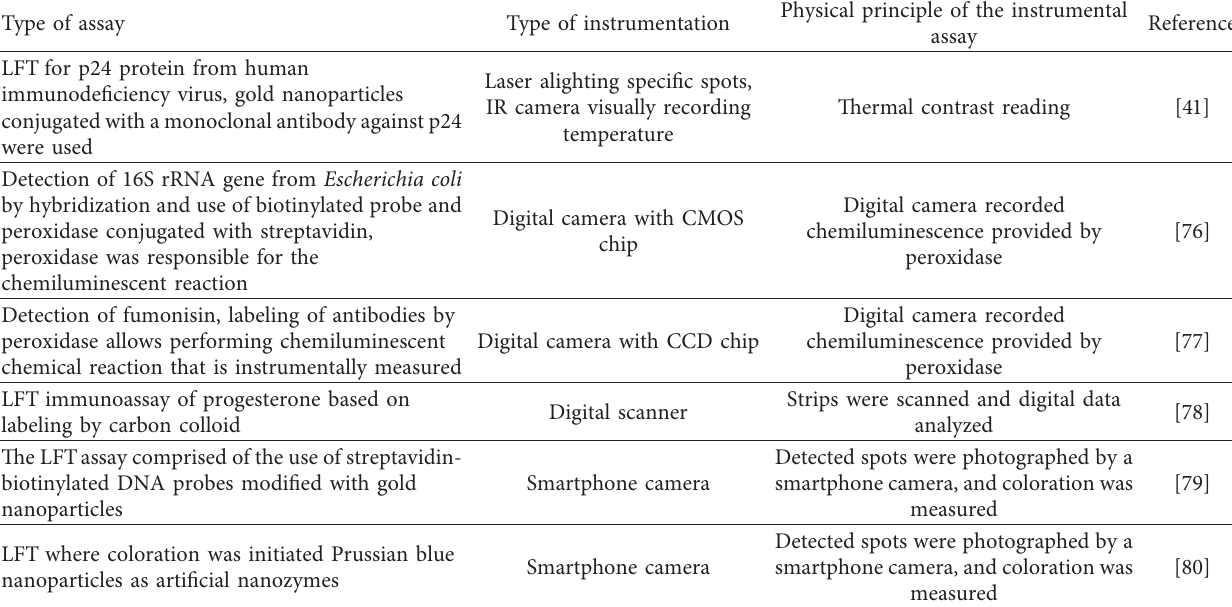
Table 2: LFT signal recording by an analytical